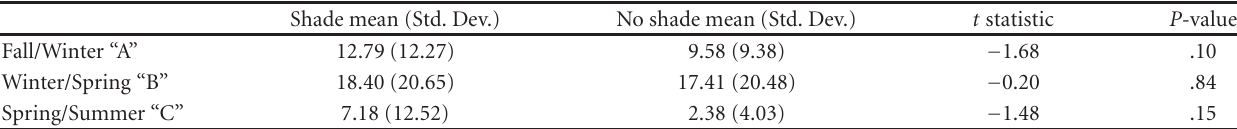
Table 3: Mean duration in days of M. bovis persistence in the environment on corn, hay, water and soil samples in season “A”, “B”, and “C” in shaded and nonshaded conditions.